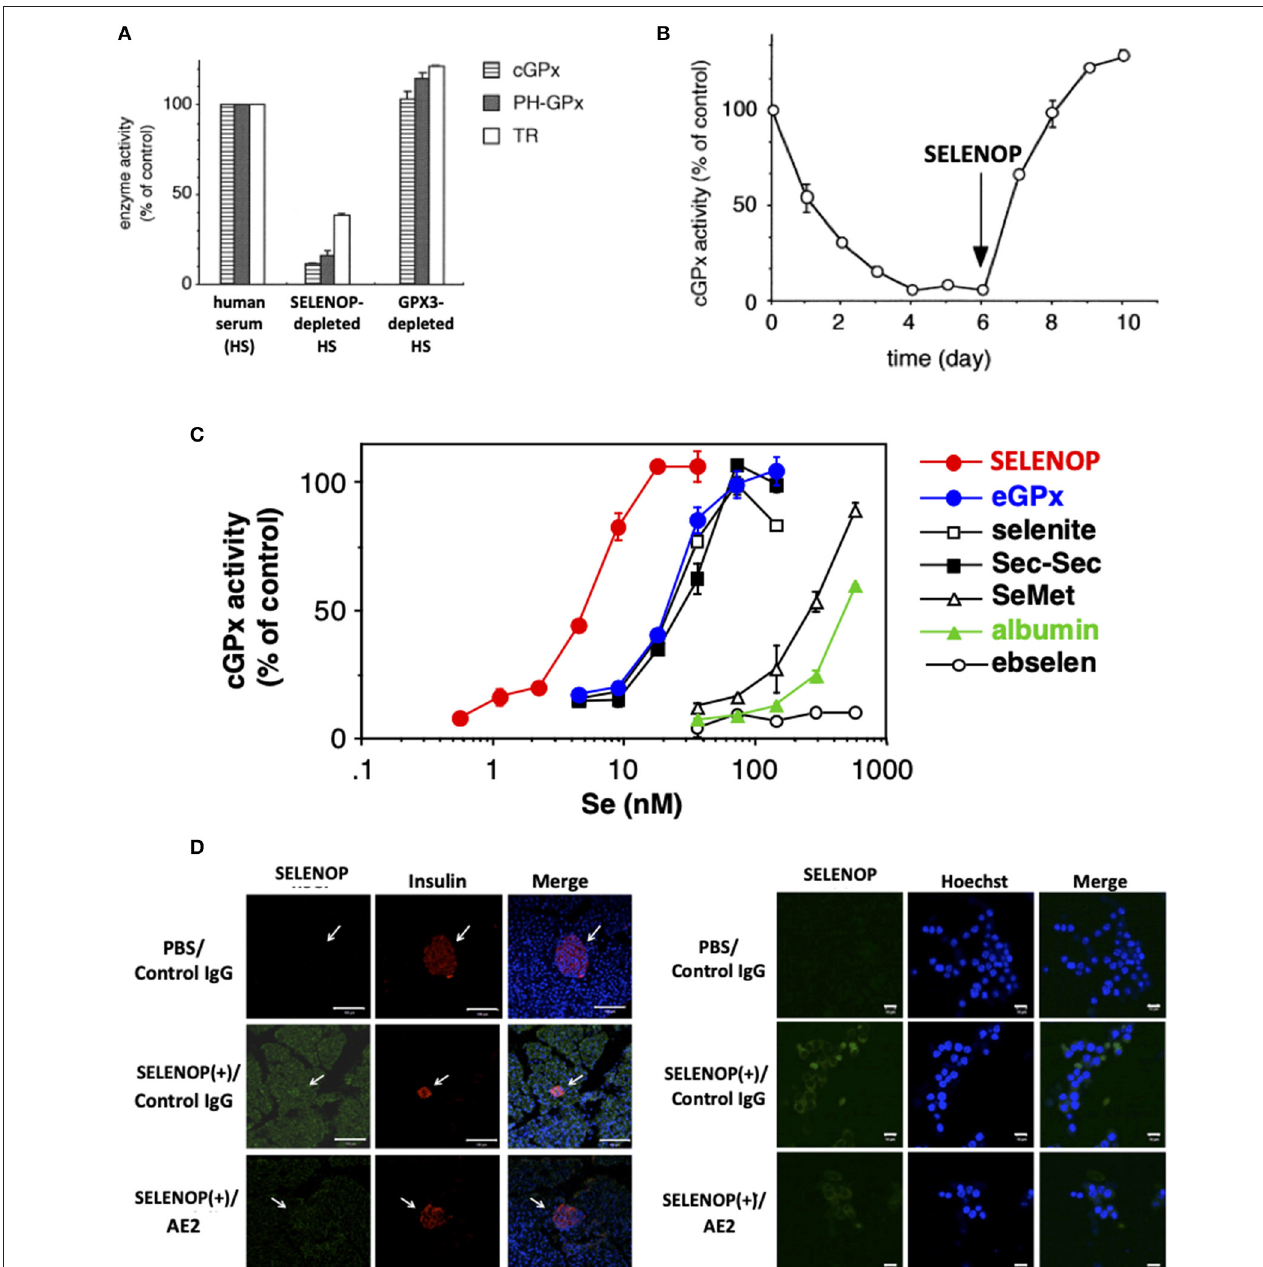
FIGURE 2 | Se transport activity of SELENOP. (A) Effect of serum selenoprotein depletion on cellular selenoenzyme activities. The Jurkat cells were cultured for 3 days in a medium containing each human serum. (B) Effect of SELENOP on cGPX activity. The Jurkat cells were cultured in a medium containing SELENOP-depleted human serum, and cGPX activity was measured. After 6 days, purified SELENOP was added. (C) Effect of the addition of Se-containing materials on cGPX activity. In the presence of variable amounts of Se-containing materials, the Jurkat cells were cultured with SELENOP-depleted serum. (D) Immunohistochemical analysis of incorporated human SELENOP. Left panel. SELENOP-neutralizing monoclonal antibody (mAb) AE2 improved pancreatic β -cell area. Pancreas tissues from neutralizing mAbAE2- and human SELENOP-treated mice were examined immunohistochemically using anti-insulin Ab (indicative of β -cells) and anti-human SELENOP Ab. Cell nuclei were stained with DAPI (blue). The distribution of human SELENOP in pancreatic β -cells was decreased in mice administered with AE2. Right panel. MIN6 cells were incubated with 10 µ g/ml human SELENOP in the presence of AE2 and control IgG (500 µ g/ml) for 48h. Treated MIN6 cells were examined immunohistochemically using anti-human SELENOP Ab. [ A–C , (9) with permission and modifications: 5051220115395, D, reference (34) with permission:CC-BY].